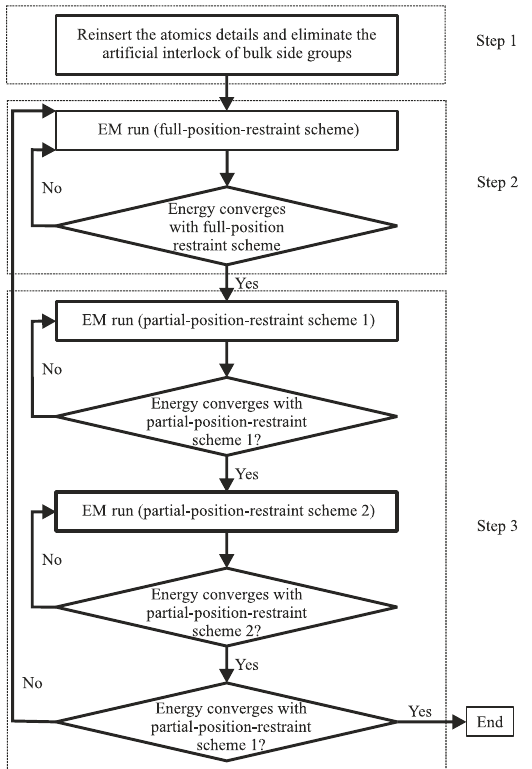
Figure 10. The workflow used in the backmapping procedure of nonequilibrium CG simulations as proposed by Chen et al. [423]. Notice that schemes 1 and 2 in step 3 are two variants of the main scheme in step 2 in order to minimize the isolation of segments from the rest of the chain. Reproduced from Chen et al. [423] with permission of the PCCP Owner Societies.